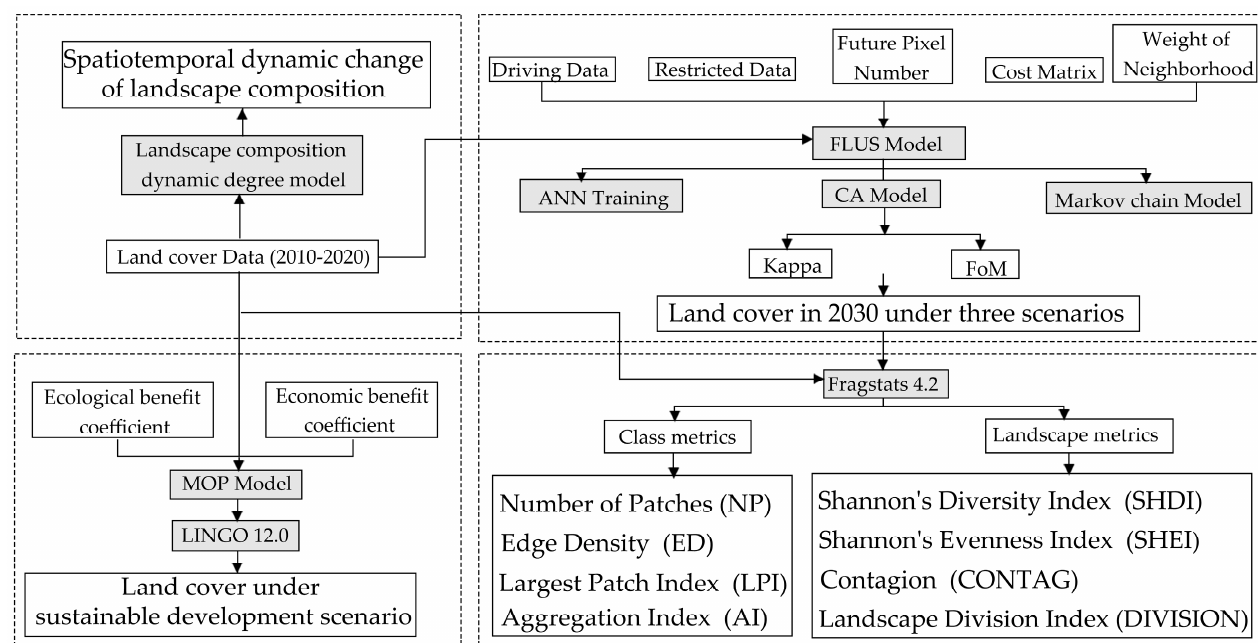
Figure 2. Technical flow chart.